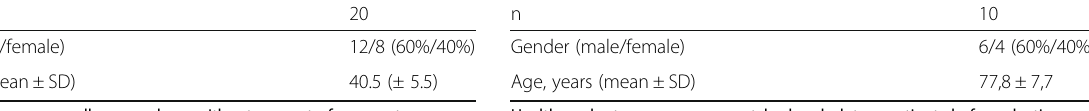
Table 5 Whole blood samples: Healthy